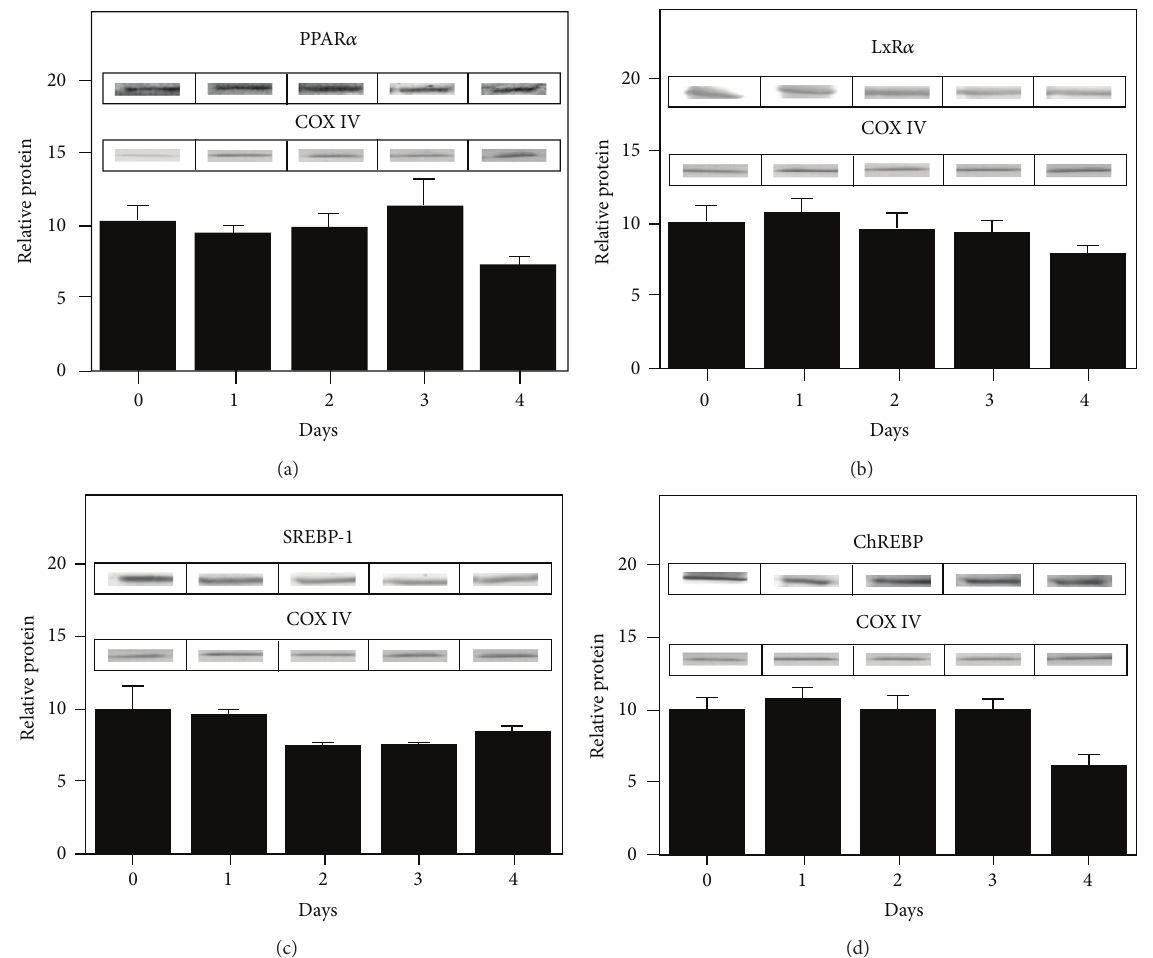
Figure 11: Expression of key nuclear receptors involved in fatty acid and glucose metabolism as a function of time. Primary hepatocytes were isolated from mouse livers and maintained in culture for up to four days as described in Methods. Representative western blots relative to a housekeeping protein (COX-1) are shown in the inserts. Quantitative analysis of multiple western blots relative to housekeeping protein was shown as black bars for PPAR 𝛼 (Panel a), LXR 𝛼 (Panel b), SREBP1 (Panel c), and ChREBP (Panel d) as described in Methods. Time 0 = concentration in liver while time of 1–4 days indicates time in culture. Mean ± SEM, 𝑛 = 3 – 6